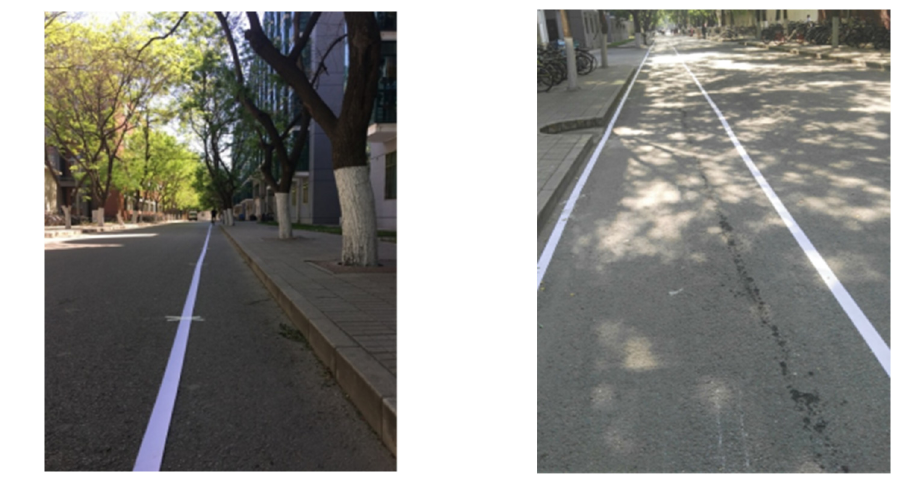
Figure 2. Cycling workload scenarios—different widths.